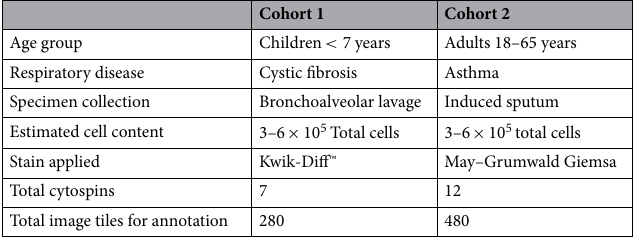
Table 1. Source of clinical respiratory samples and variations in cytospin